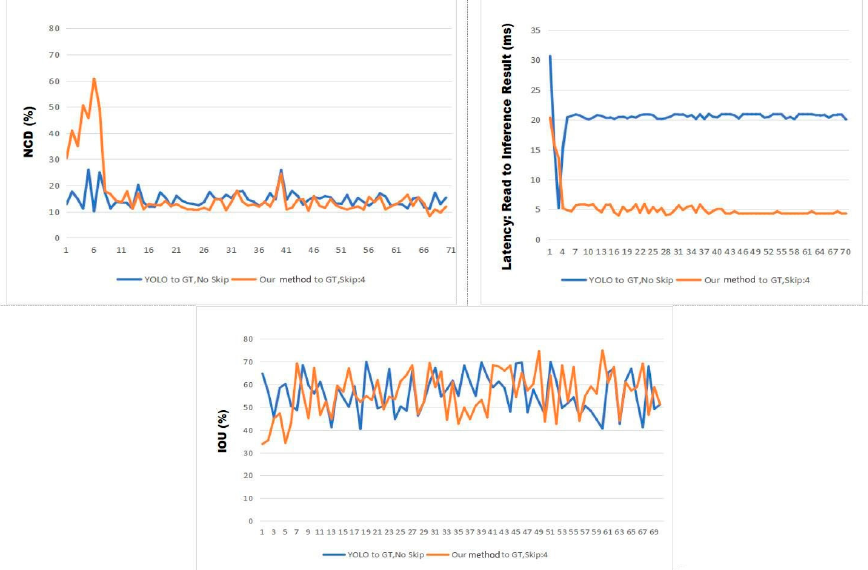
Figure 6. Metrics for walking OTB sequence with basic spin-lock latency smoothing enabled at frame 40.